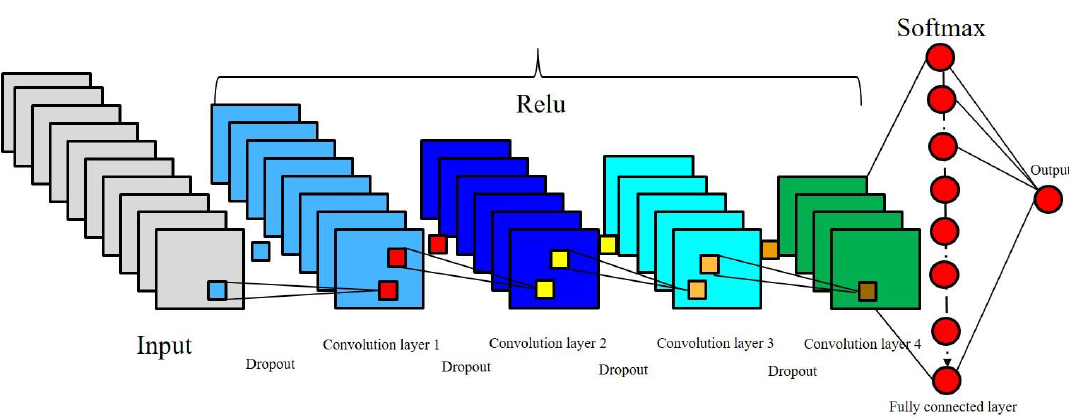
Figure 3. Architecture of the convolutional neural network (CNN) model for prediction of earthquake classification.